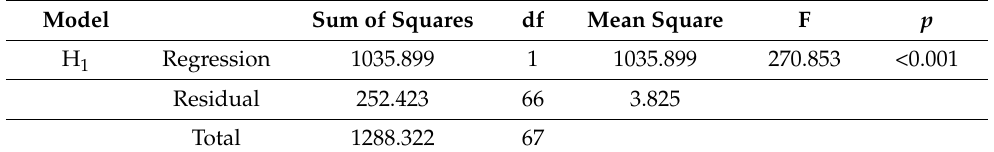
Table 14. Horizontal dry plate method and wet candle method—ANOVA.